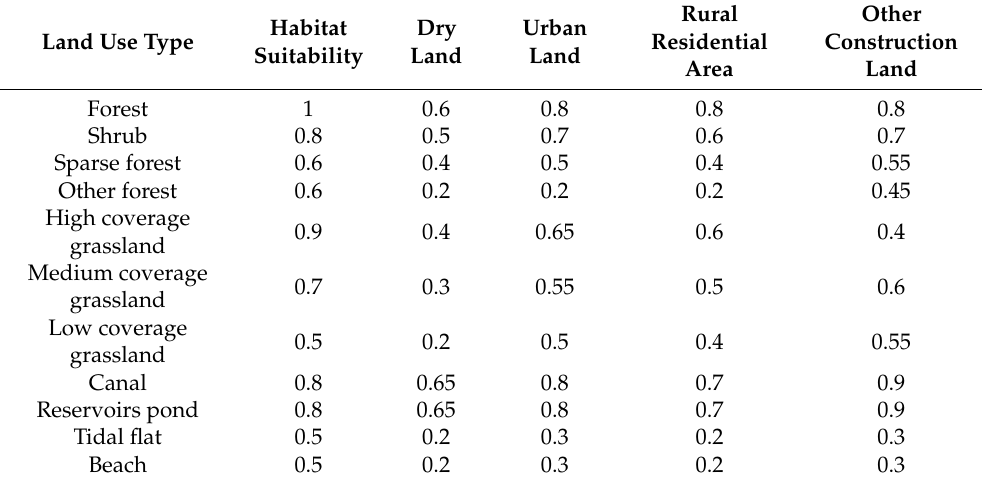
Table 2. Sensitivity parameters of land use types to threat